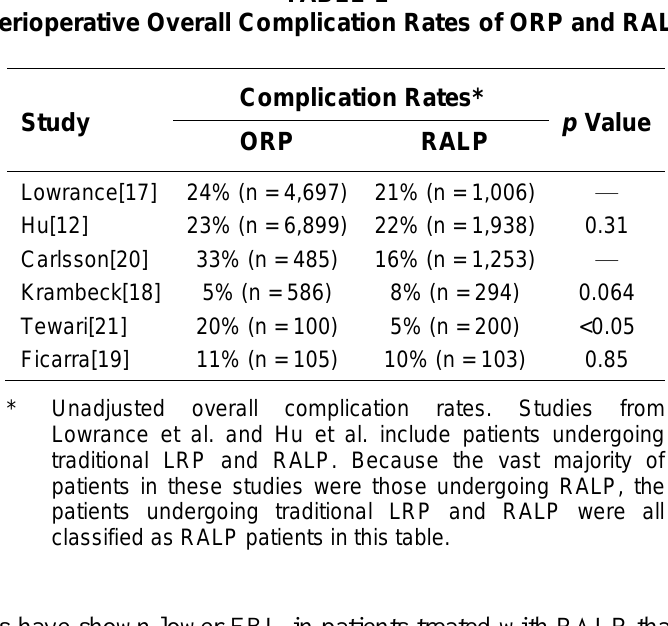
Perioperative Overall Complication Rates of ORP and